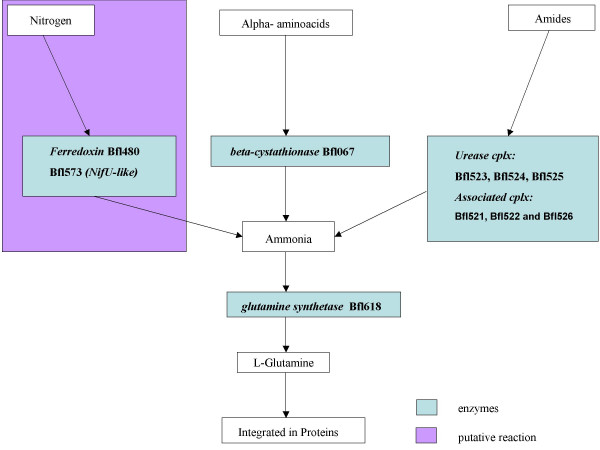
Nitrogen metabolism. The identified previously known and newly predicted enzyme activities of Blochmannia are compiled for the pathway of nitrogen metabolism. They involve the urease complex (Bfl523, Bfl524 and Bfl525; catalyzing the following reaction: Urea + H2O = CO2 + 2 NH3) and urease activating complex (Bfl521, Bfl522 and Bfl526) and glutamine synthetase (Bfl618). Further proteins adding to the pathway are the now confirmed ferredoxin (Bfl 480), Bfl 573 (NifU-like protein; previously conserved hypothetical) as well as beta-cystathionase (Bfl067).